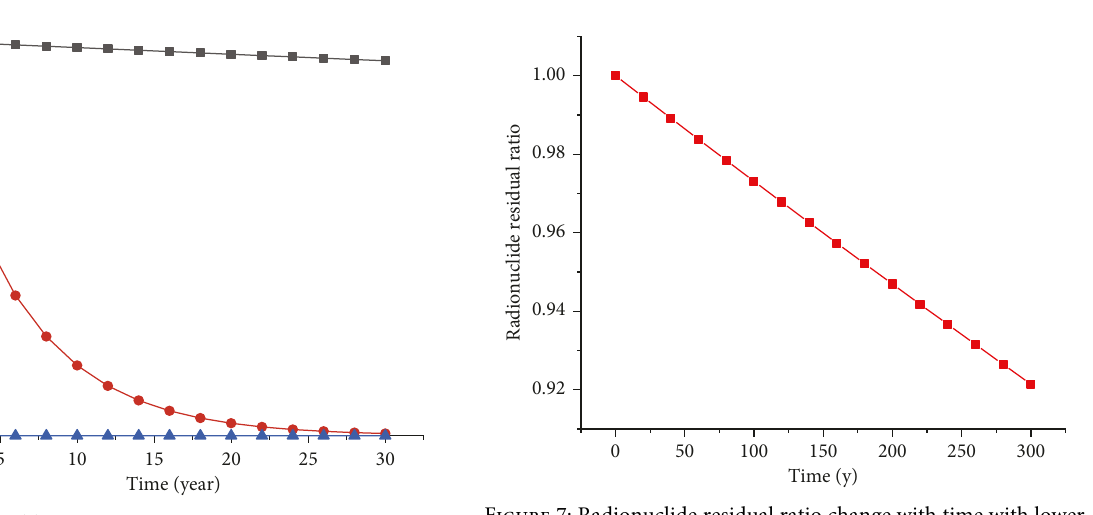
Figure 5: Radioactivity changes of different radionuclides with time. (a) Radioactivity changes within 300 days. (b) Radioactivity changes within 20